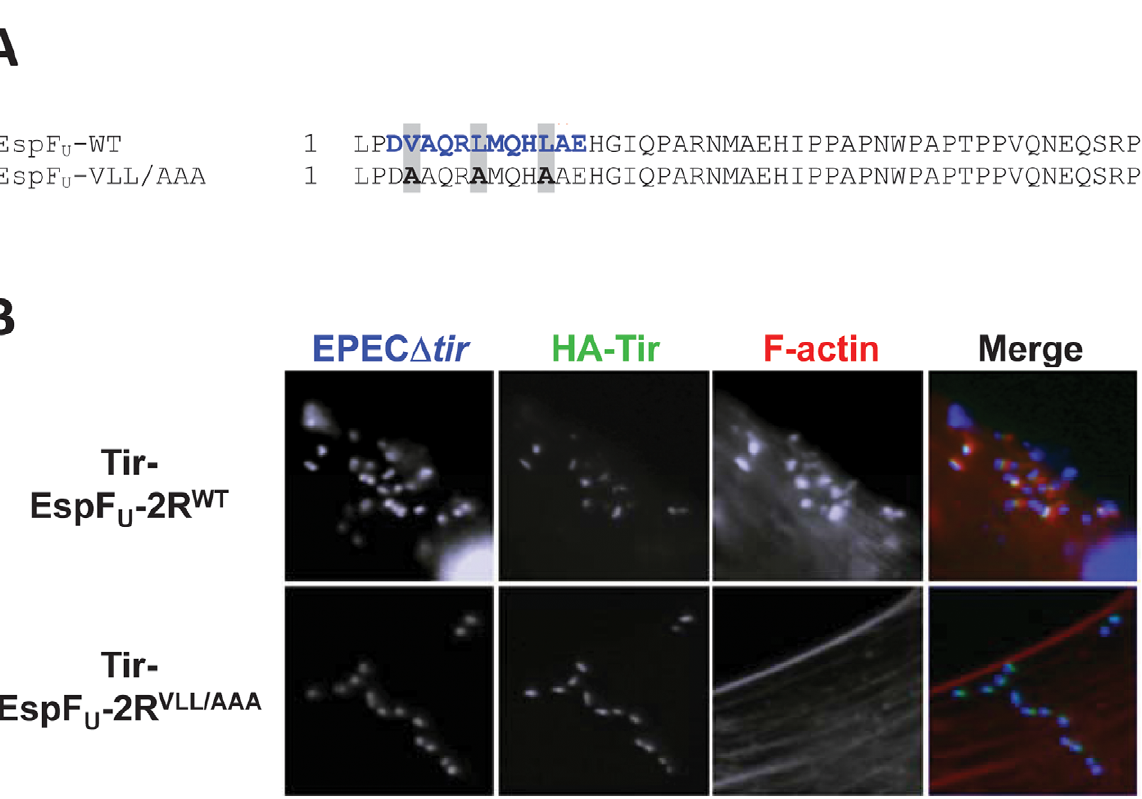
Figure 9. The WASP/N-WASP-binding region of EspF U is required for N-WASP-independent actin pedestal formation. ( A ) Sequence alignment of an EspF U repeat and the corresponding VLL/AAA mutant. The WASP/N-WASP-binding a -helix is colored in blue. ( B ) NW 2 / 2 FLCs ectopically expressing HA-Tir-EspF U -2R WT or HA-Tir-EspF U -2R VLL/AAA fusions were challenged with an EPEC D tir strain (which expresses intimin), and stained with DAPI (blue), anti-HA antibody (green) and Alexa568-phalloidin